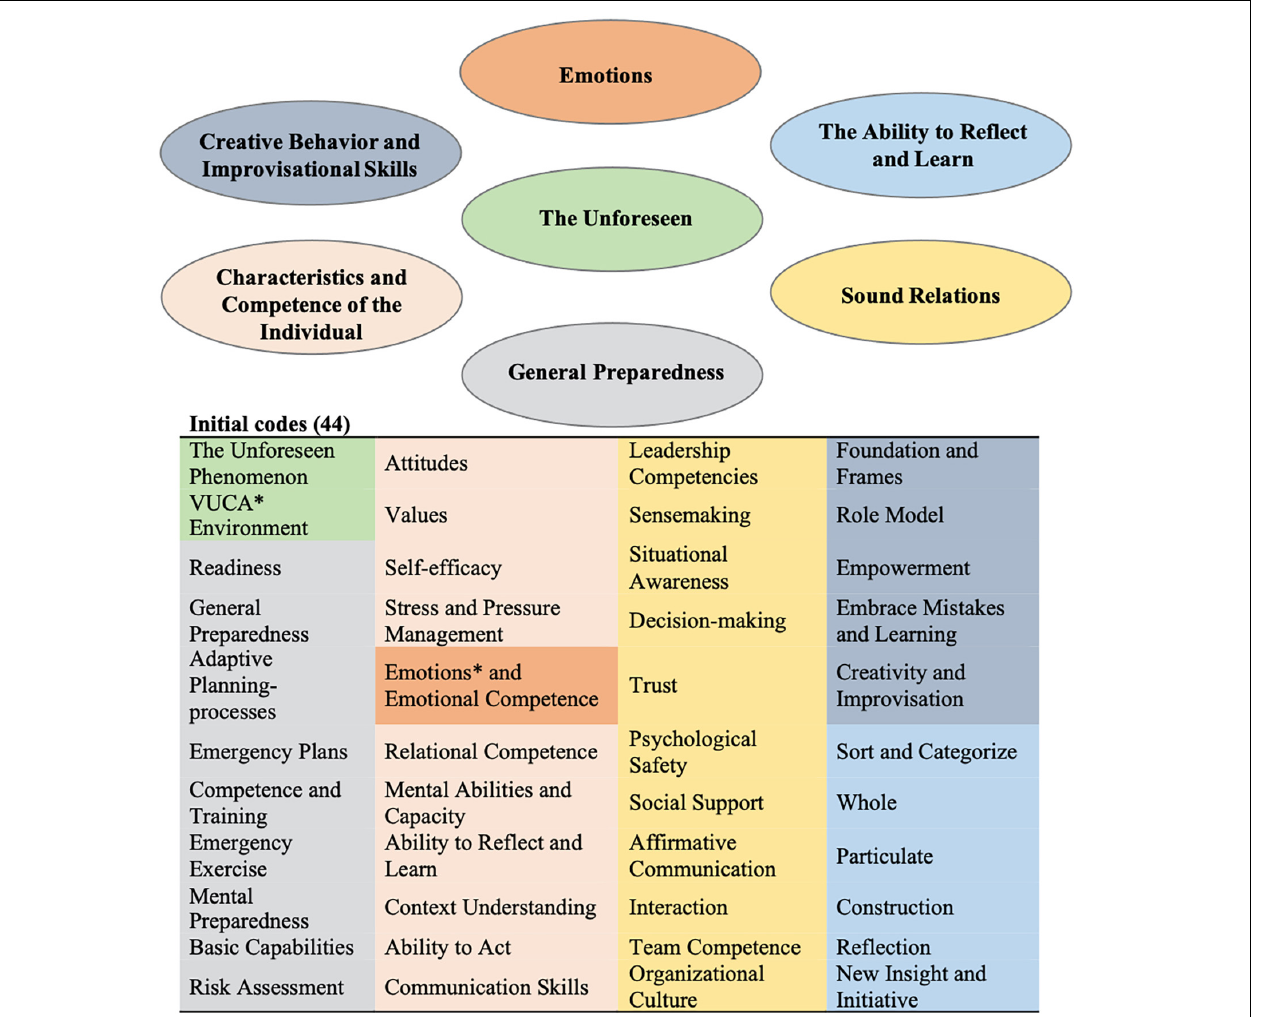
FIGURE 1 | Map of overall themes derived from initial coding. The colored background represents the linking and grouping of the initial codes into emerging overall themes. ∗ VUCA, Volatile, Uncertain, Complex, and Ambiguous (Barber, 1992). ∗ Emotions emerged as a main theme evident across all professional experts. Initial sub-coding of emotions: negative emotions, positive emotions, fear, shock, panic, surprise, interest, mood, language, metaphors, metaphorical expressions, sensemaking, levels of emotions, emotional capital, emotional intelligence, emotional dissonance, emotional incongruence, emotionally contagious.